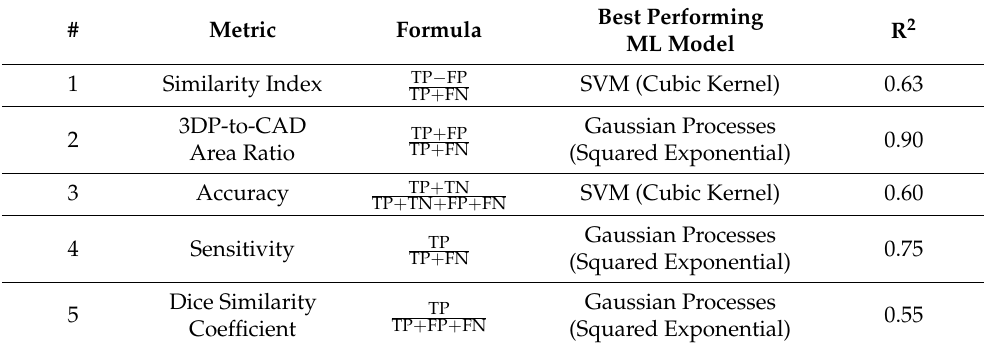
Table 4. Performance of ML algorithms for the extracted similarity